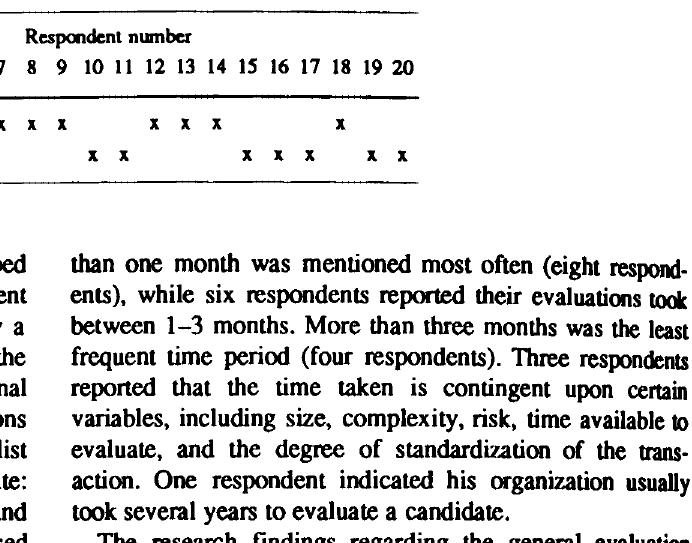
Table 2 Use of formally developed evaluation